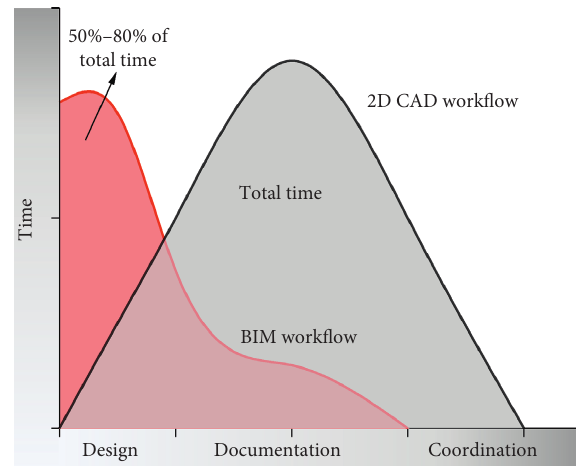
Figure 5: The changes of the design and documentation happened in the workflow.